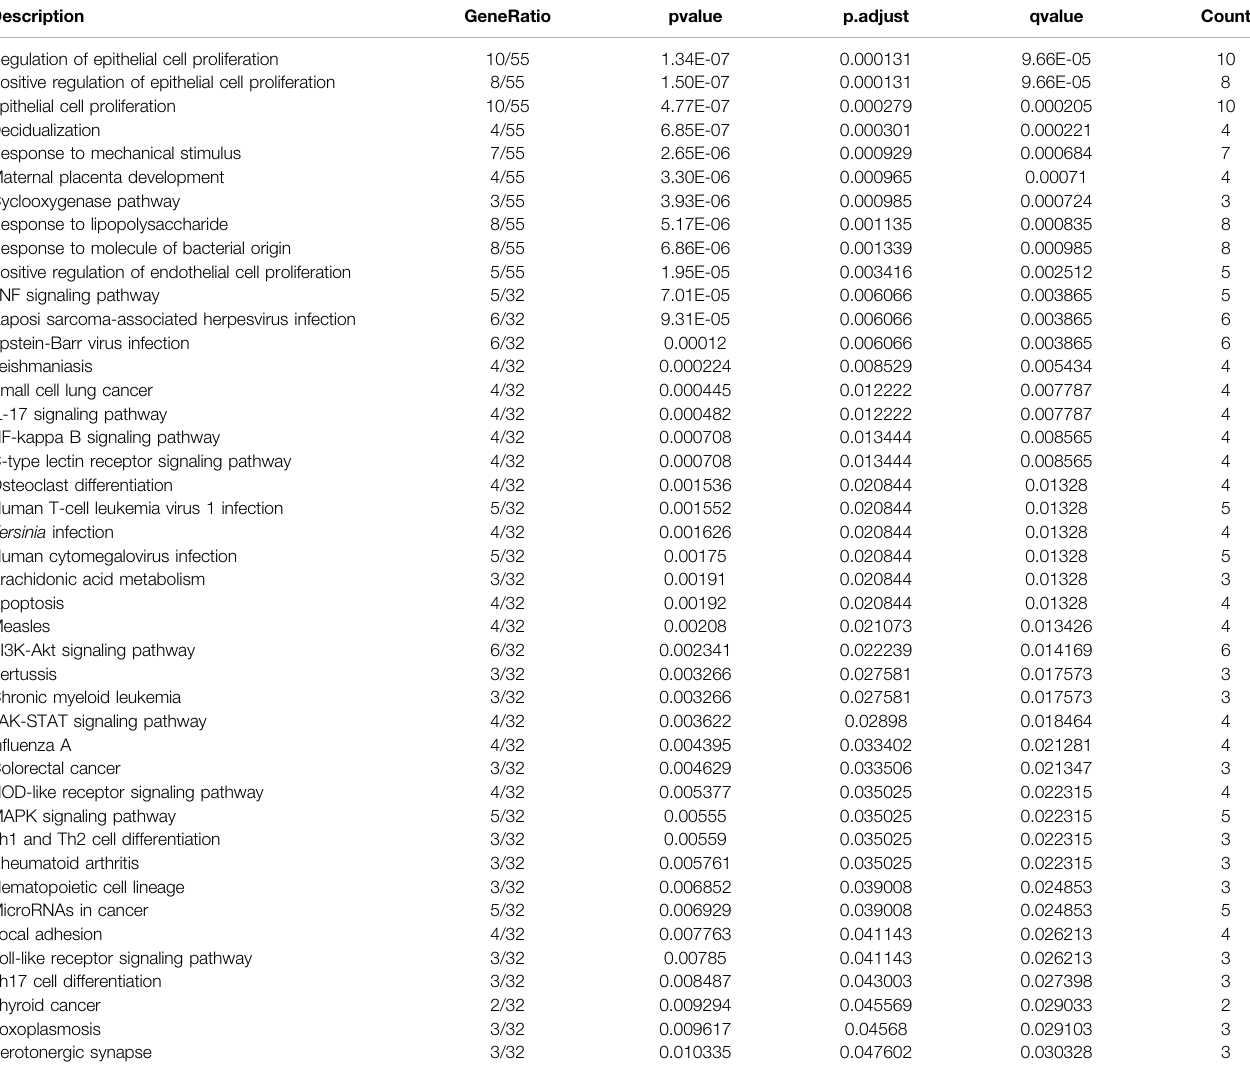
TABLE 2 | The detailed information of GO and pathway enrichment analysis results.